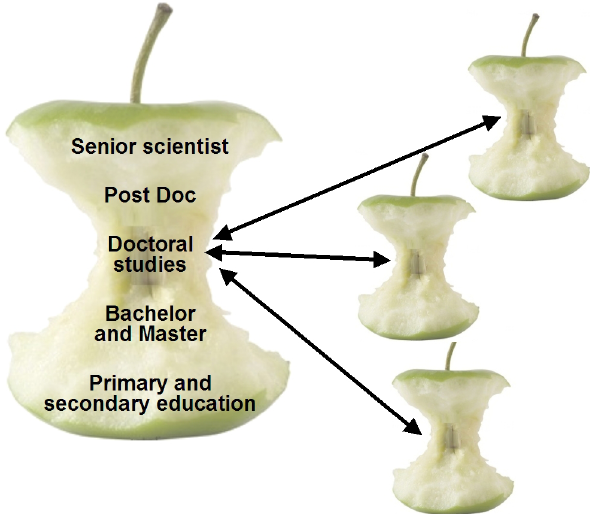
Fig. 2. Apple core concept of education: the width of the apple shows the breadth of topics covered at each stage of education. Doc- toral studies are narrow, focussed and deep. A significant feature of the Doctoral Programme is that all candidates are constantly ex- posed to the specialist work of other candidates (illustrated by the other apples with arrows showing interaction) thereby raising their capacity to relate to other areas of